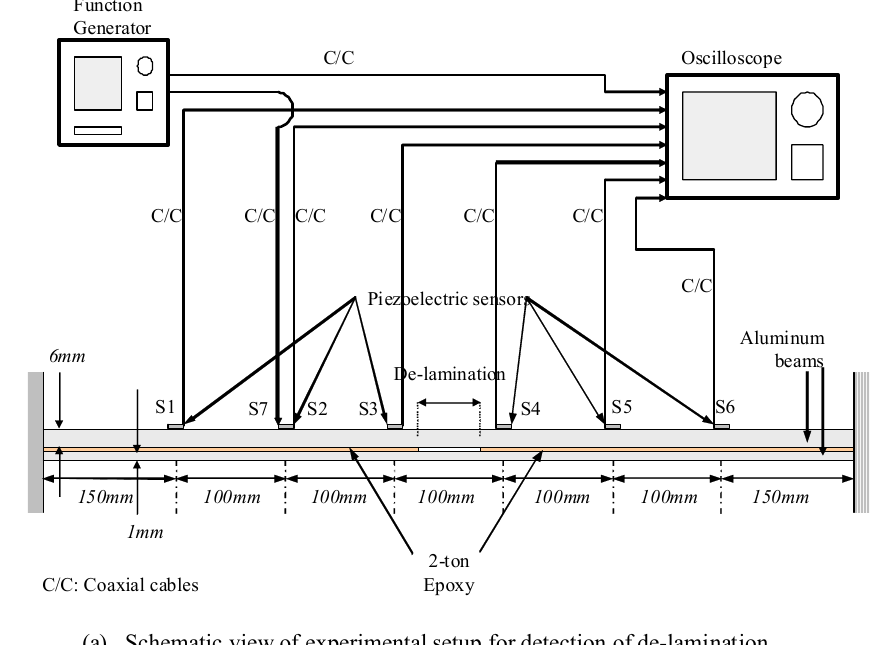
Figure 5. Experimental set-up to detect the delamination in beam (adopted from Figure 8 in [18]).